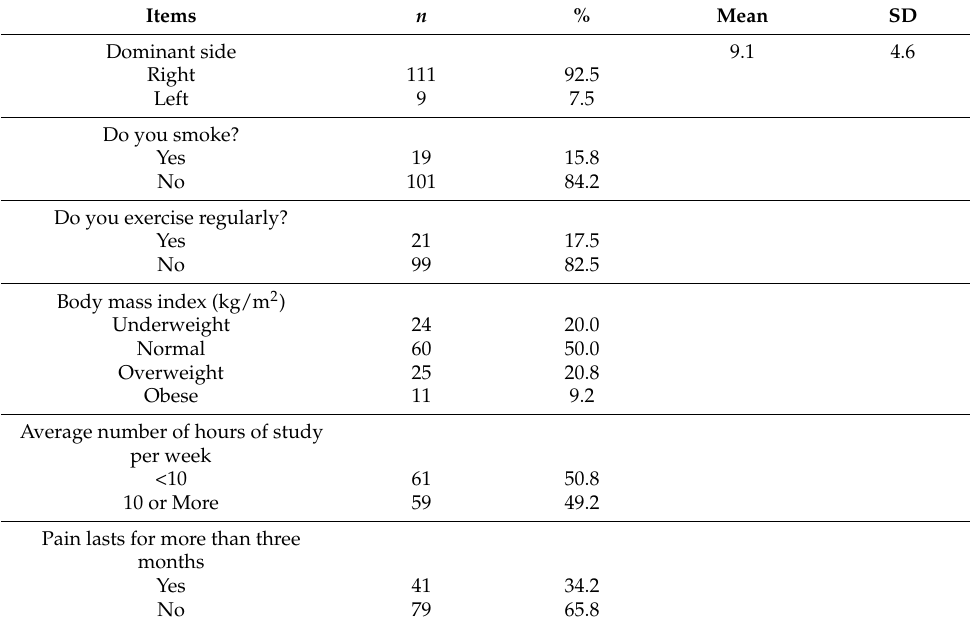
Table 2. Number and distribution of the life style of the students.